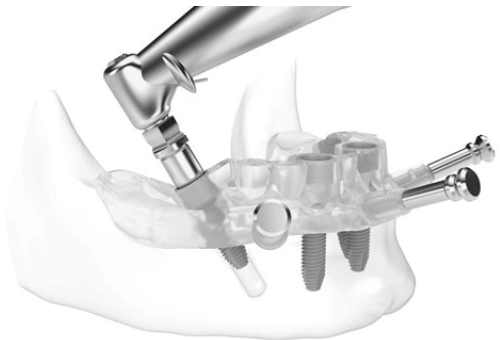
Figure 3. Just-on-4 surgical work-flow with a mucosa-supported template.